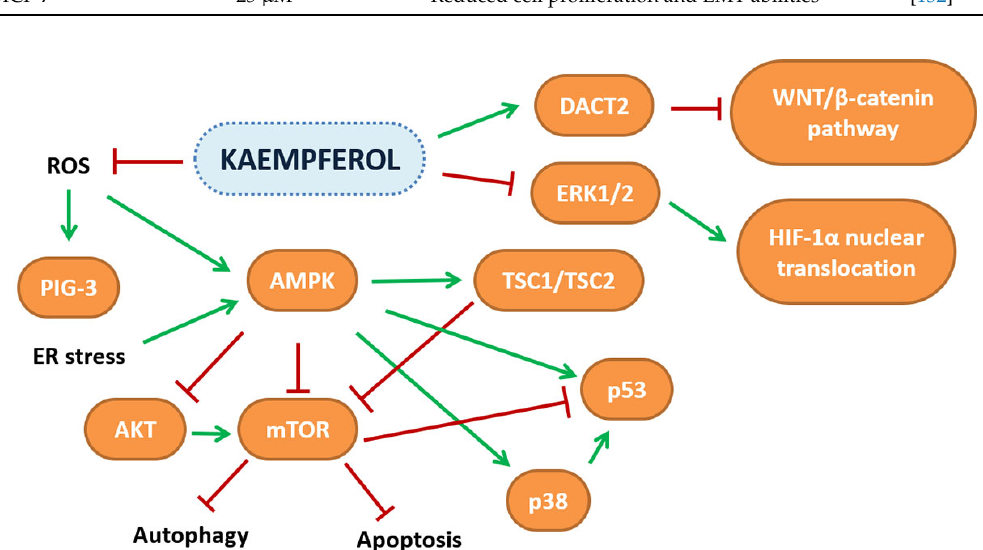
Figure 3. Schematic representation of the pathways affected by kaempferol in several in vitro and in vivo cancer models.